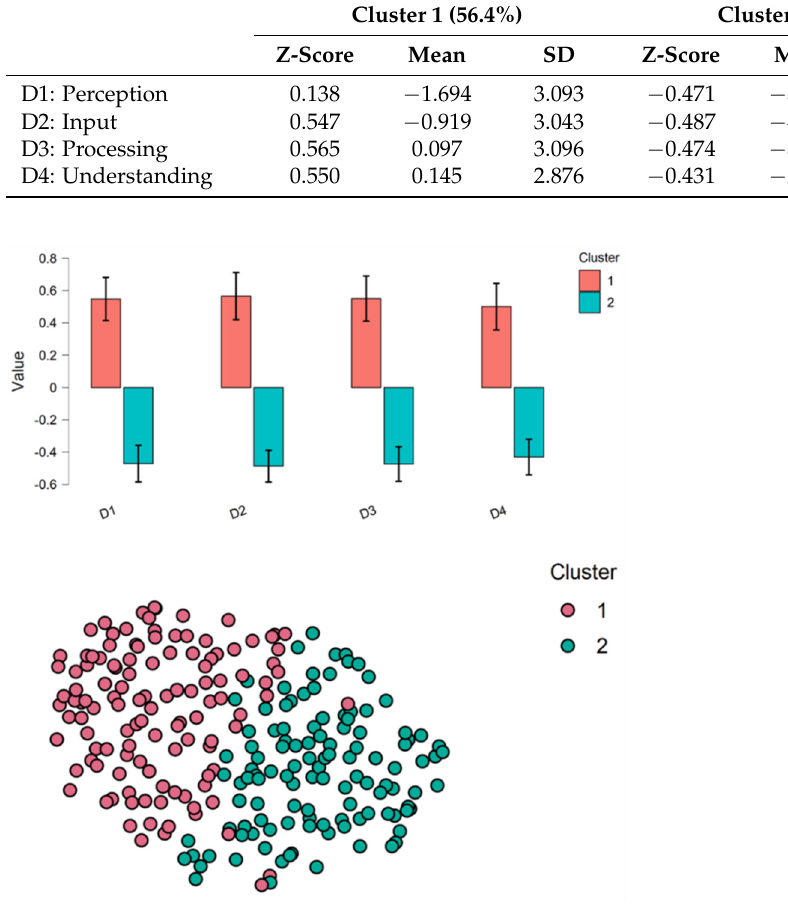
Figure 2. Cluster mean plots and t-SNE cluster plot.